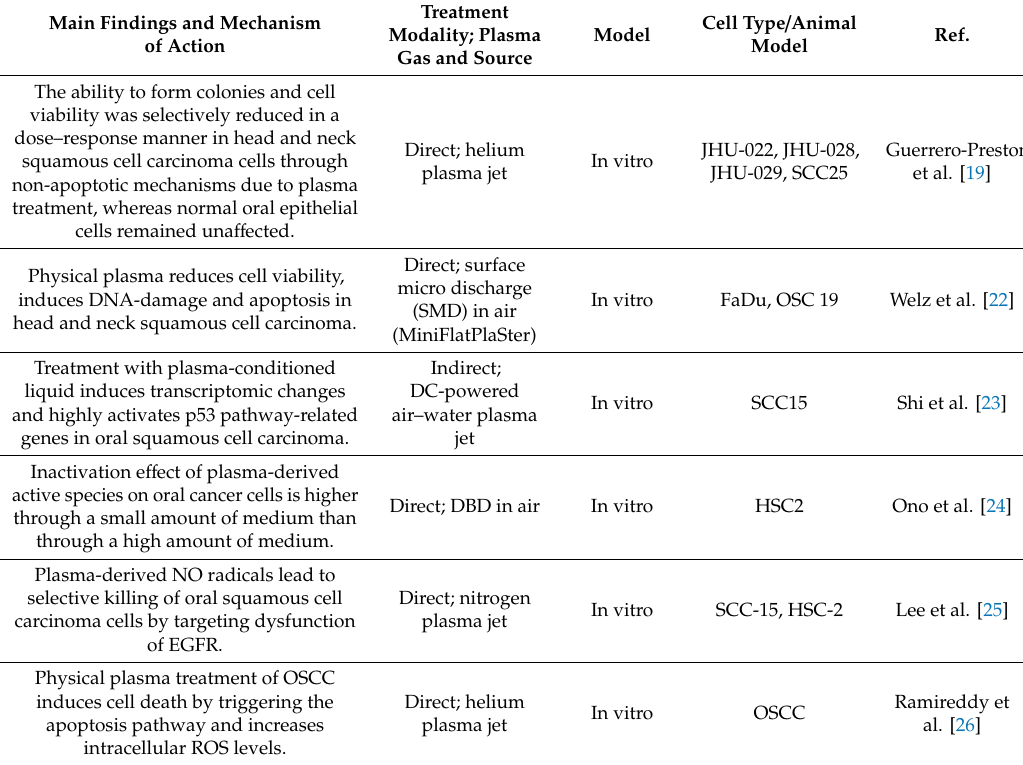
Table 1. Biological e ff ects of physical plasma in head and neck cancer cells in vitro and in vivo. DBD: dielectric barrier discharge; direct: immediate exposure of tissue or cells in culture vessels to gas plasma system; indirect: exposure of a liquid to gas plasma treatment and either immediate or delayed addition of this plasma-conditioned liquid to cells in culture or injection into the tissue. ATM: ataxia-telangiectasia mutated, EGFR: epidermal growth factor receptor, MAPK: mitogen-activated protein kinase, MMP: mitochondrial membrane potential, OSCC: oral squamous cell carcinoma, ROS: reactive oxygen species, TfR: